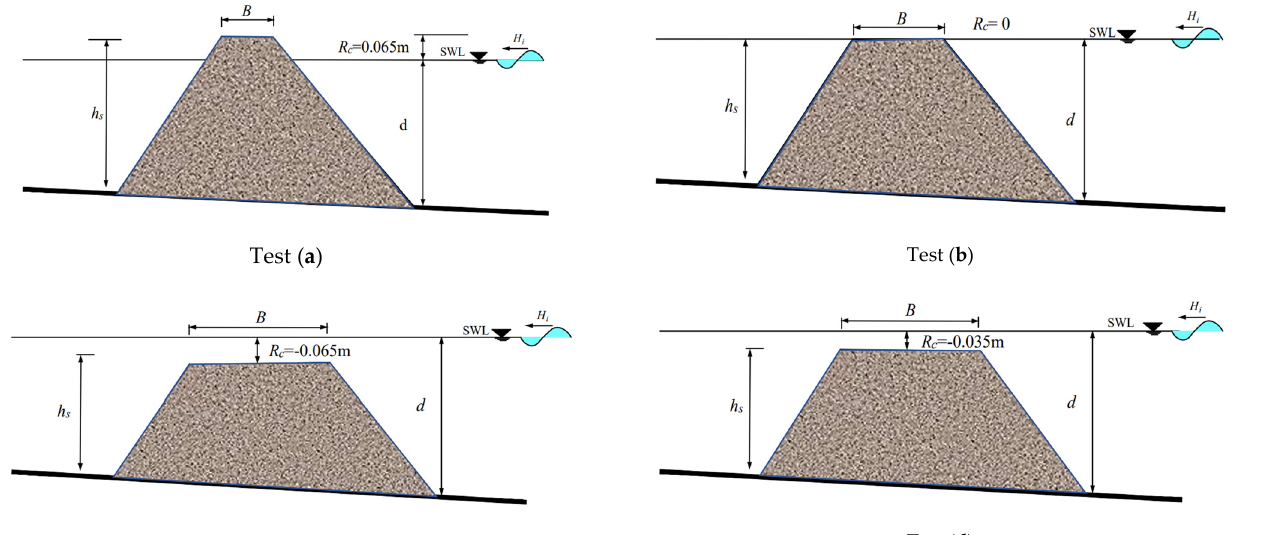
6 of 20 Figure 2. Schematic view of the wave flume and experimental arrangement for measuring incident, transmitted, and reflected wave fields in the wave flume.